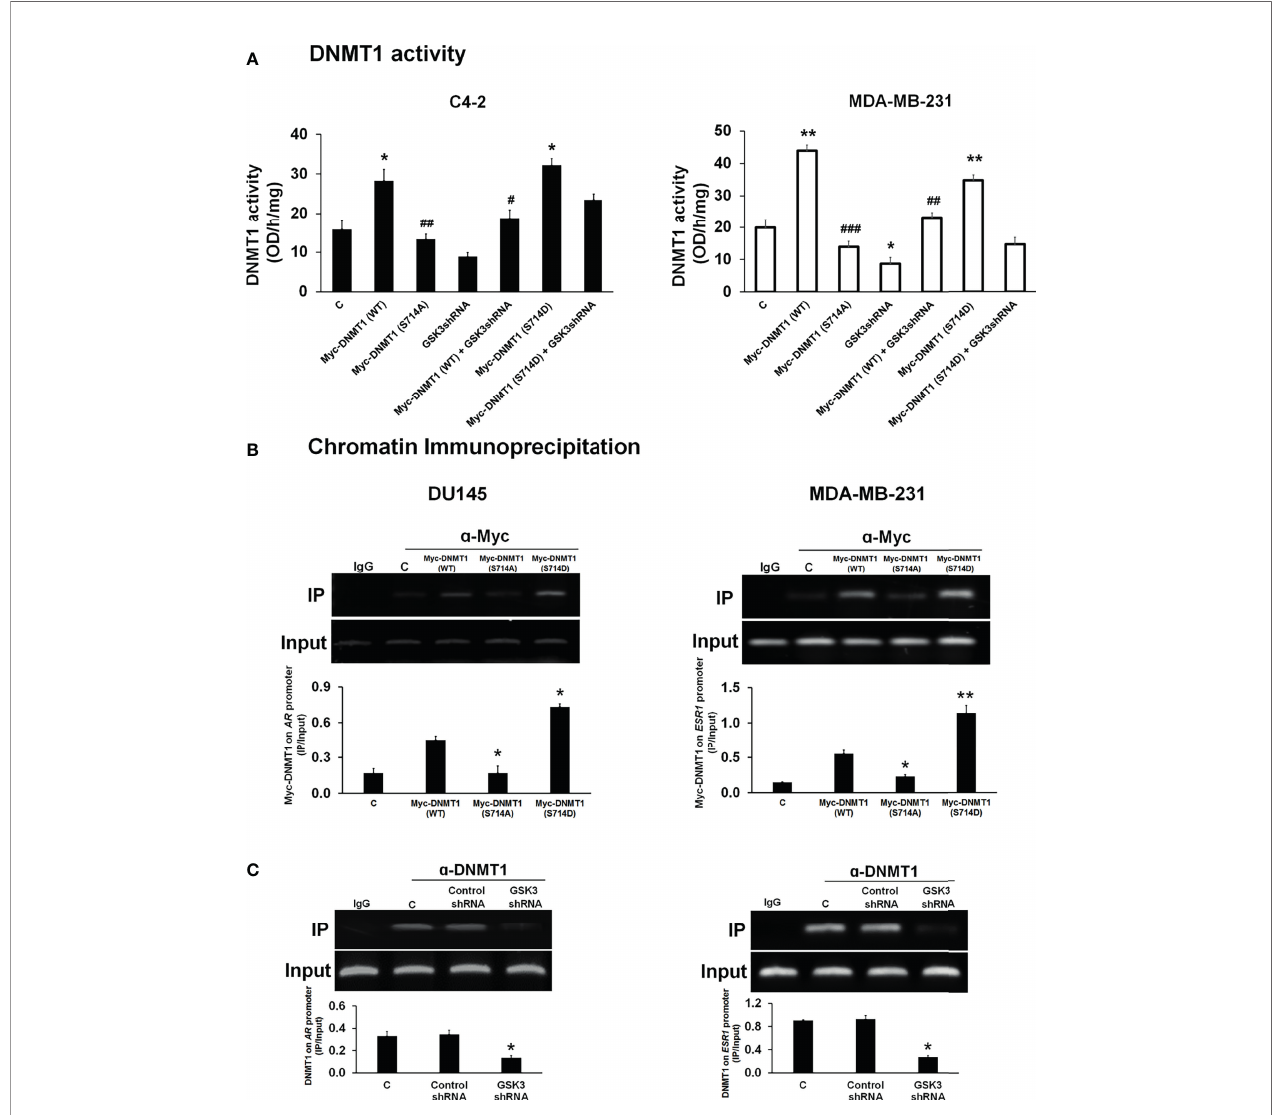
FIGURE 3 | Modulation of DNMT1 activity and DNA binding by phosphorylation at S714. (A) Nuclear extracts were generated from C4-2 and MDA-MB-231 cells transfected with expression vectors for Myc-DNMT1 (WT), Myc-DNMT1 (S714A), Myc-DNMT1(S714D) and/or transduced with GSK3 shRNA lentiviruses. DNMT activity (methylation of CpG-rich sequences immobilized on 96-well plates) was assessed according to the manufacturer ’ s protocol. Figures are representative of at least 3 independent experiments. *P<0.05 and **P<0.01 vs . Control. # P<0.05 and ## P<0.01, and ### P < 0.001 vs . DNMT1 (WT). (B) DU145 and MDA-MB-231 cells were transfected with expression vectors for Myc-DNMT1 (WT), Myc-DNMT1 (S714A), or Myc-DNMT1(S714D). Cells were processed for ChIP analyses of the recruitment of Myc-tagged proteins on the AR promoter in DU145 cells and on the fi rst exon of the ESR1 gene in MDA-MB-231 cells. Input DNA was used as normalization control. IgG control was used as a negative control. The gel images are representatives of 3 independent experiments. *P<0.05 and **P<0.01 vs . Myc-DNMT1 (WT). (C) DU145 and MDA-MB-231 cells were infected with control or GSK3 shRNA lentiviruses targeting GSK3 a and GSK3 b and selected using puromycin. Cells were then processed for ChIP analyses of recruitment of DNMT1 to the AR promoter in DU145 cells and to the fi rst exon of the ESR1 gene in MDA-MB-231 cells. Input DNA was used as normalization control. IgG control was used as a negative control. Figures are representative of at least 3 independent experiments. *P<0.05 vs .